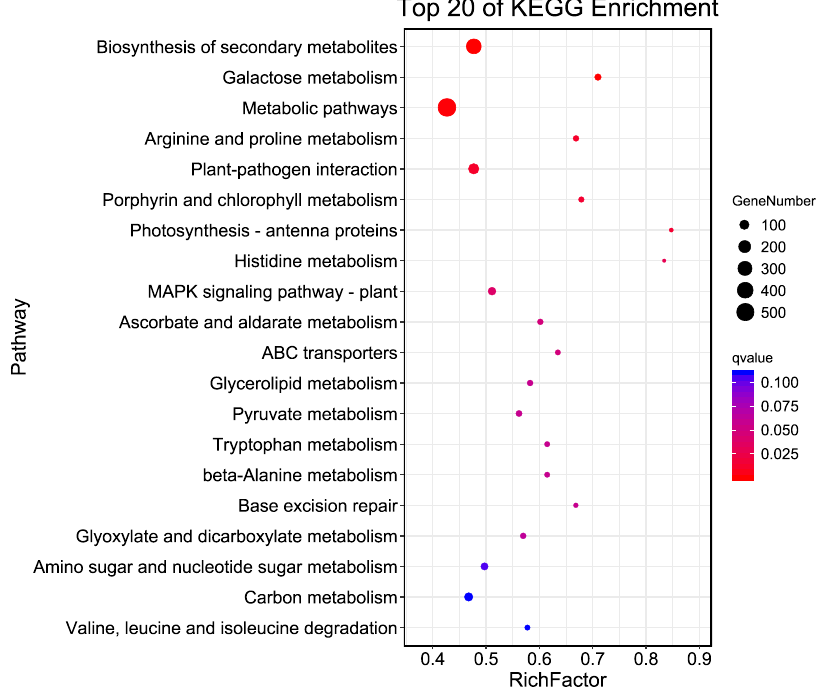
Figure 3. The top 20 enriched pathways under drought treatment for 15 d compared to that at 0 d. Rich factor represents the ratio of the number of DEGs in the pathway.